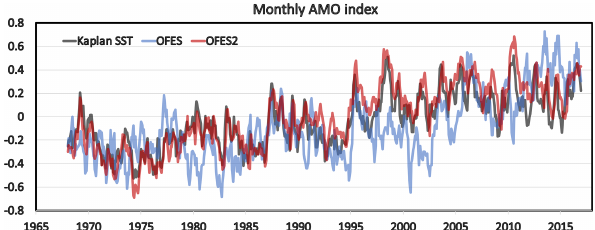
Figure 12. Monthly AMO index defined as SSTAs ( ◦ C) at 0 ◦ S– 70 ◦ N in the eastern topical Pacific in the Kaplan SST (black curve; Kaplan et al., 1998; https://psl.noaa.gov/data/timeseries/AMO/, last access: 15 July 2020), OFES2 (red curve), and OFES (blue